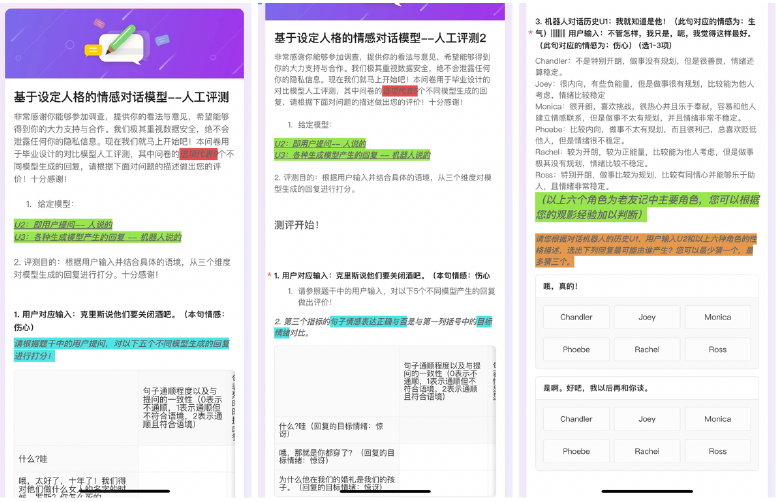
Figure 2. Three sets of human evaluation questionnaire preview. All volunteers were native Chinese speakers, so all questions in the questionnaire were in